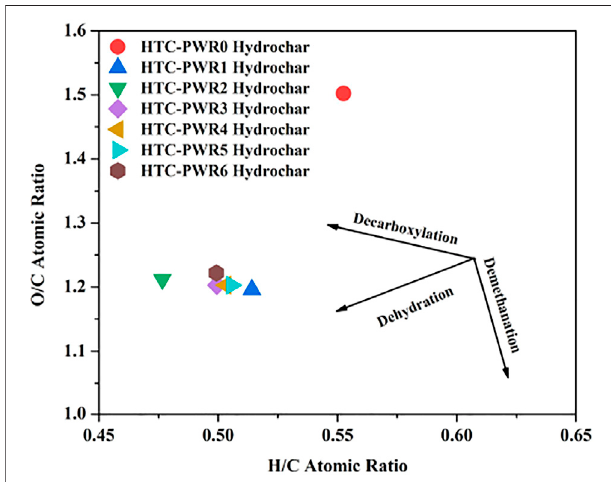
FIGURE 4 | Effects of process water recirculation on HHV of wheat straw hydrochar.